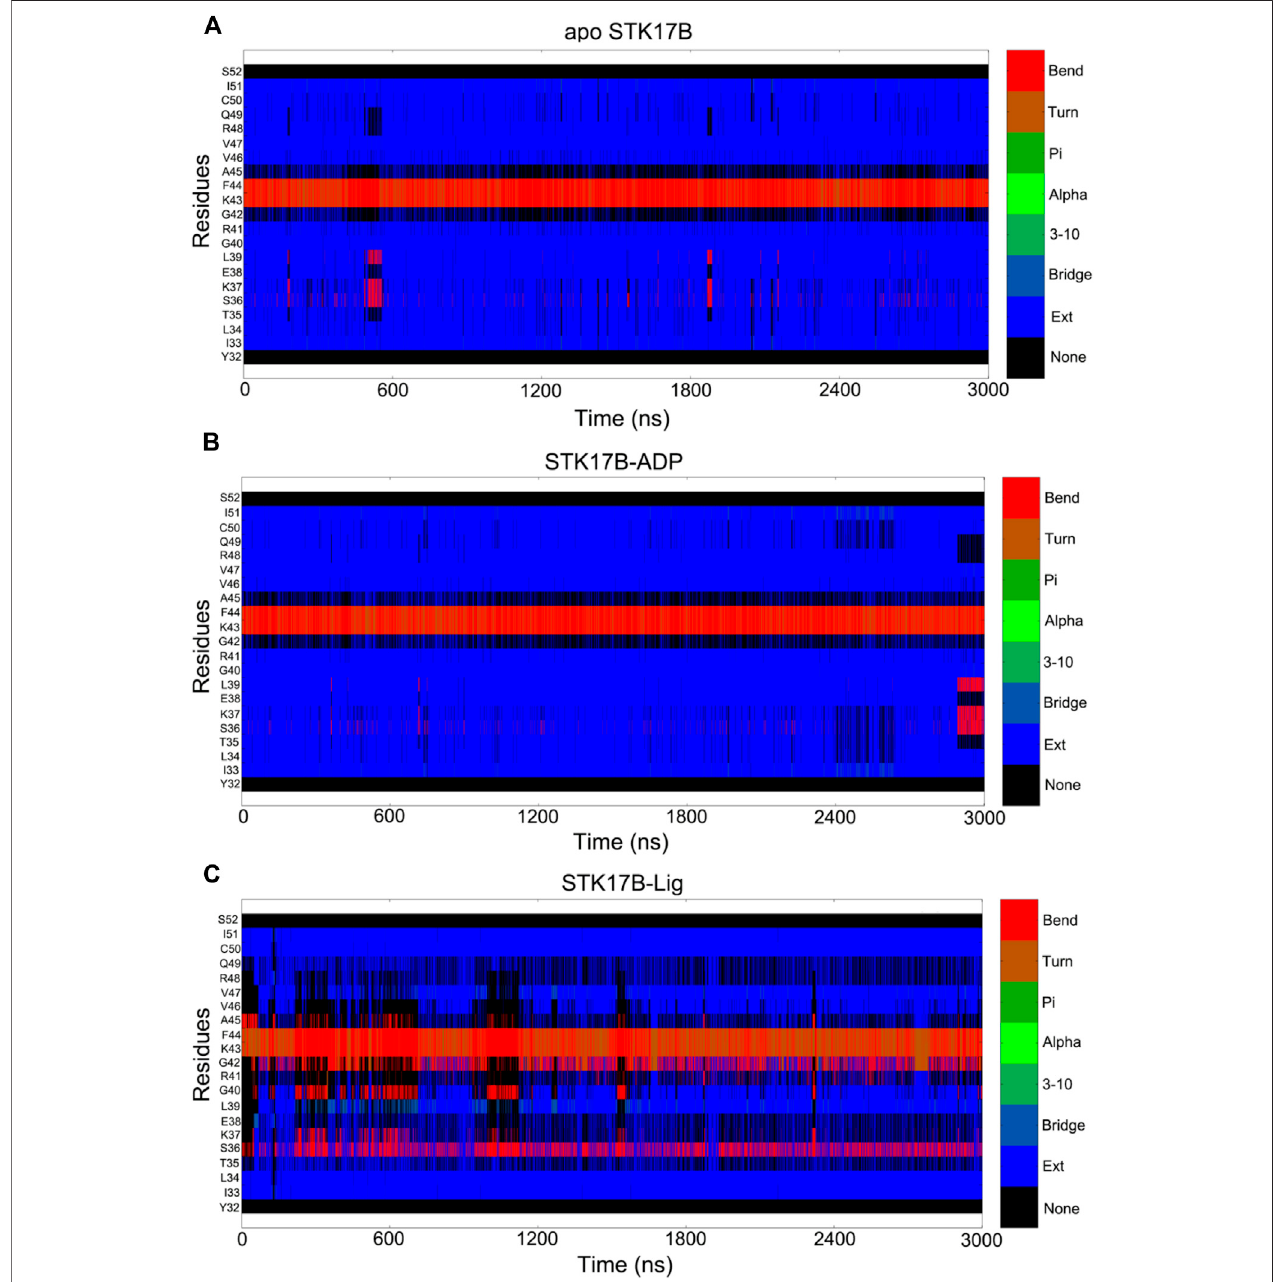
FIGURE6| SecondarystructuralelementanalysisasafunctionofsimulationtimeforresiduesTyr32toSer52intheapo (A) ,ADP-bound (B) ,andligand-bound (C) systems as calculated using the de fi ned secondary structure of proteins (DSSP) method.